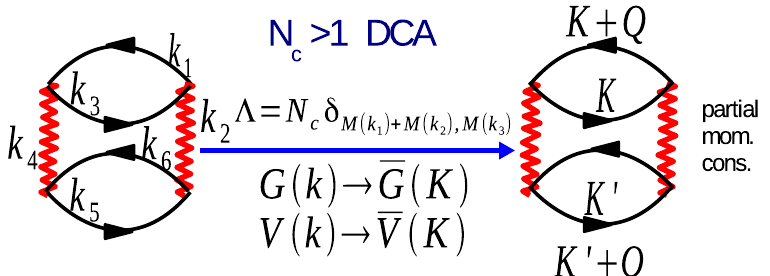
Figure 21. A second-order term in the generating functional of the Hubbard model. Here the undulating line represents the interaction U , and on the LHS (RHS) the solid line the lattice (coarse-grained) single-particle Green’s functions. When the DCA Laue function is used to describe momentum conservation at the internal vertices, the momenta collapse onto the cluster momenta and each lattice Green’s function and interaction is replaced by the corresponding coarse-grained result.